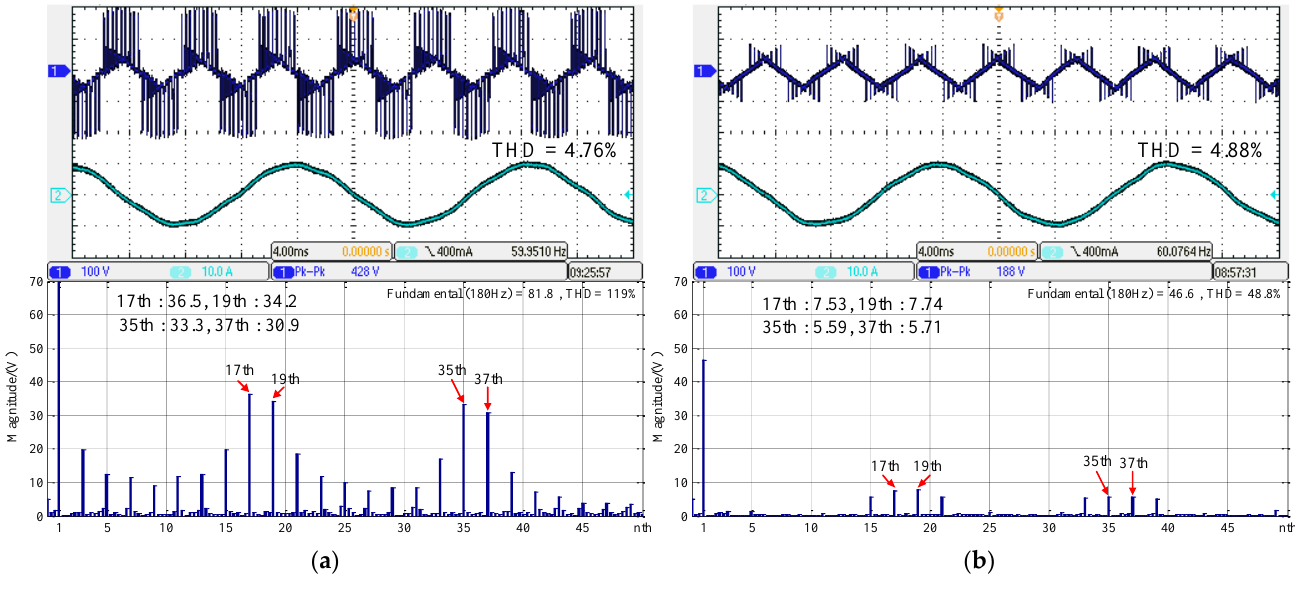
Figure 12. CMV and 𝑖 𝑔𝑎 ( 𝑚 𝑎 = 0.833): ( a ) SVM1 and ( b ) SVM2. Figure 12. CMV and i ga ( m a = 0.833): ( a ) SVM1 and ( b ) SVM2. Table 3 summarizes HF-CMVs with a constant m a of 0.833 and various φ by SVM1 and SVM2. With a negative φ , SVM2 can mitigate all the listed order HF-CMVs, except the 19th ◦ order CMV, which increases by 7.4 V with φ of − 60 . With a positive φ , SVM2 can mitigate 17th and 19th order CMVs by more than two times in contrast to SVM1, but the 35th order CMV increases. The main reason is that with various phase angle differences, filter T HD = 7 . 37 % capacitor voltages associated with each space vector are varied. The shapes of generated CMVs are changed. Though the mitigation of HF-CMVs around unity control frequency can always be maintained, while the performance around higher frequency, such as double control frequency would be impacted by various phase angle differences. Due to the capacitive currents imposed by C f , filter capacitor voltages make it easier to lag inverter output PWM current, which means a negative φ . Hence, in most operating conditions, the performance of SVM2 in HF-CMV mitigation can still be